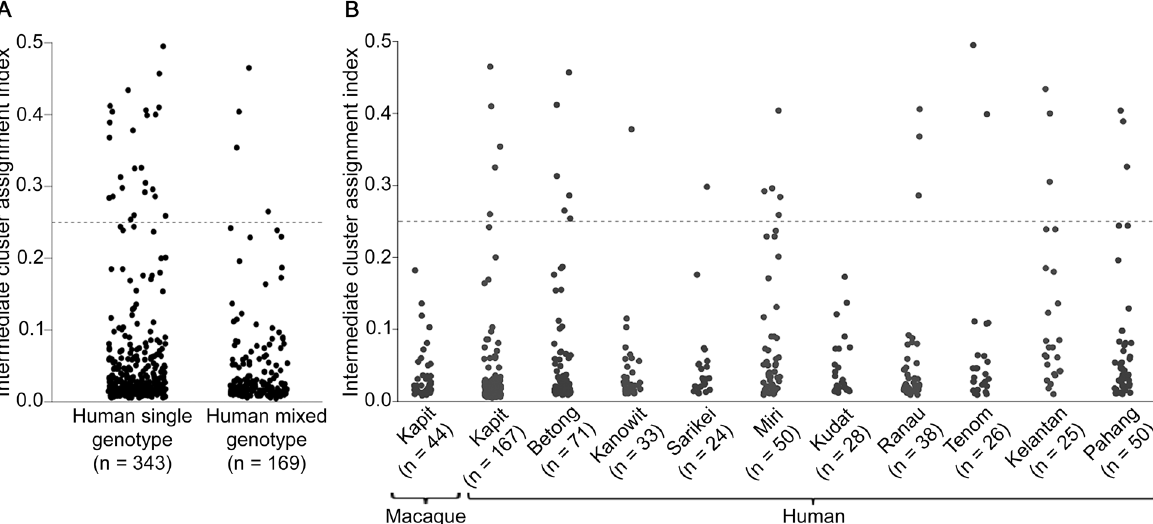
Fig 7. Intermediate cluster assignment indices in P . knowlesi infections in humans and macaques. The index for each infection was based on the proportion of shared ancestry between Cluster 1 and Cluster 2 inferred by the STRUCTURE analysis on all samples genotyped at 10 microsatellite loci. An index below 0.25 signifies the individual parasites were predominantly either Cluster 1 or Cluster 2 while those above 0.25 had more intermediate assignment (up to a maximum index value of 0.5). (A) There was no significant difference between single or multiple genotype human infections in the distribution of the indices (Mann-Whitney U test, P = 0.20). (B) Intermediate cluster assignment indices were lower in infections from macaques in Kapit than in human infections overall (Mann-Whitney U test, P < 0.001), but were not significantly different from human infections in Kapit (P = 0.25). Among geographical sites, the indices for human infections were significantly higher in Kelantan than in Kapit, Betong, Kanowit, Kudat or Ranau (P < 0.05 for each pairwise comparison after Bonferroni correction).